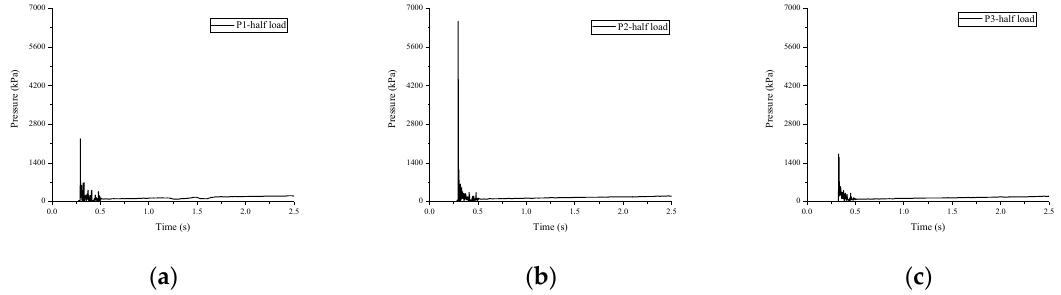
Figure 18. Pressure at P1, P2 and P3 in the case of half load: ( a ) Pressure at P1; ( b ) pressure at P2; ( c ) pressure at P3.